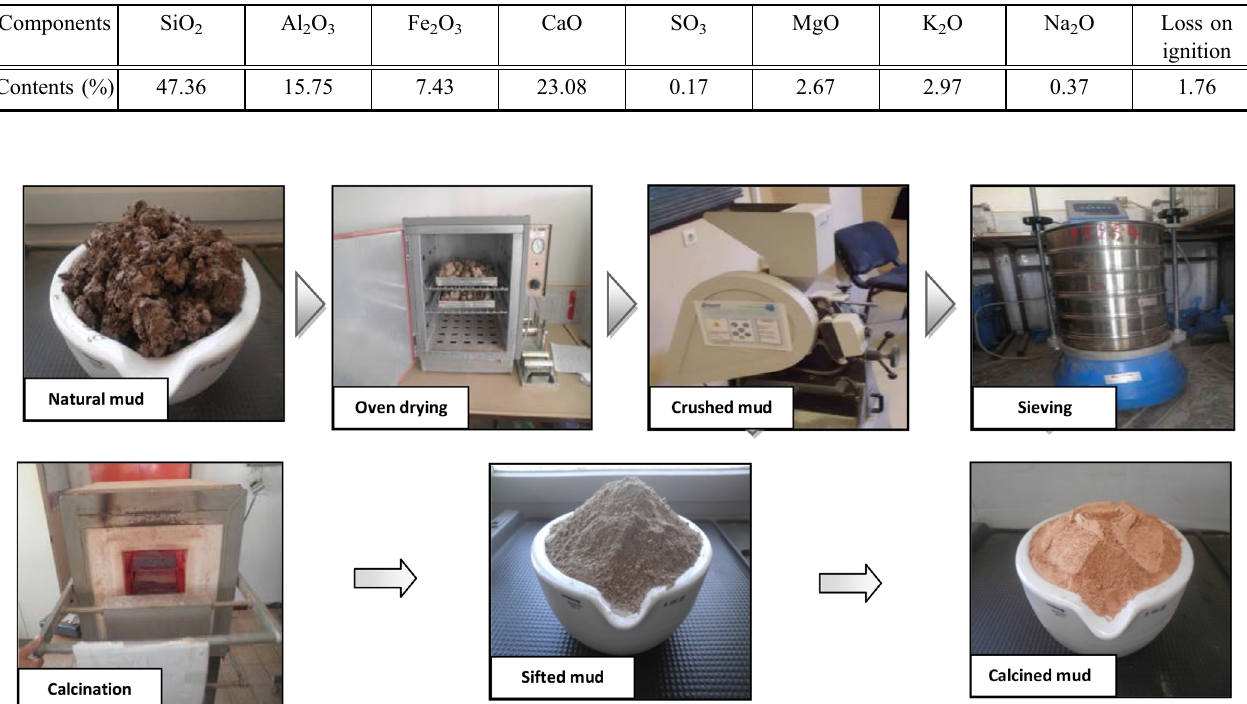
Fig. 3 Steps for mud